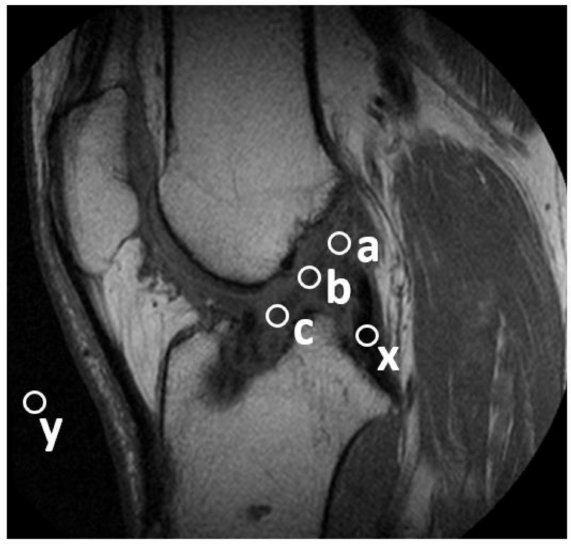
Figure 3. The locations of each region of interest used for the calculation of the SNQ are shown, includ- ing S PCL (x), S BACK (y), and the proximal (a), central (b), and distal (c) intra-articular regions, S ROI